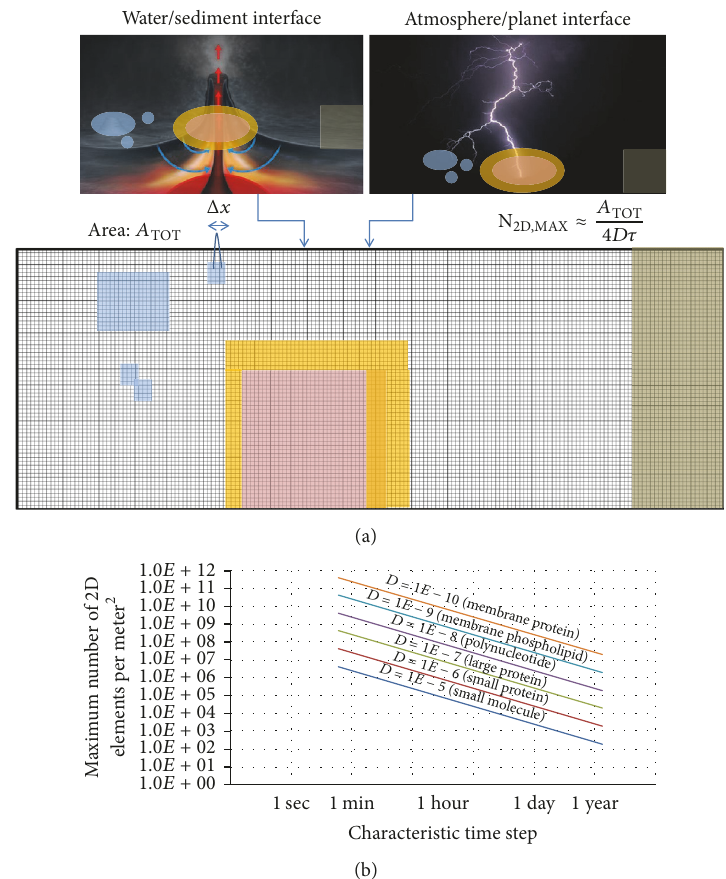
Figure 7: (a) Simplified dimensionless depiction of example 2D memory elements as subdivisions of lining surfaces of basins (top) in which compounds of interest are produced (bottom, shaded regions). (b) Maximum number of 2D diffusion-limited memory elements per square meter. The width of the lines in plot (b) corresponds to variation caused by temperatures ranging from 20 ∘ C to 250 ∘